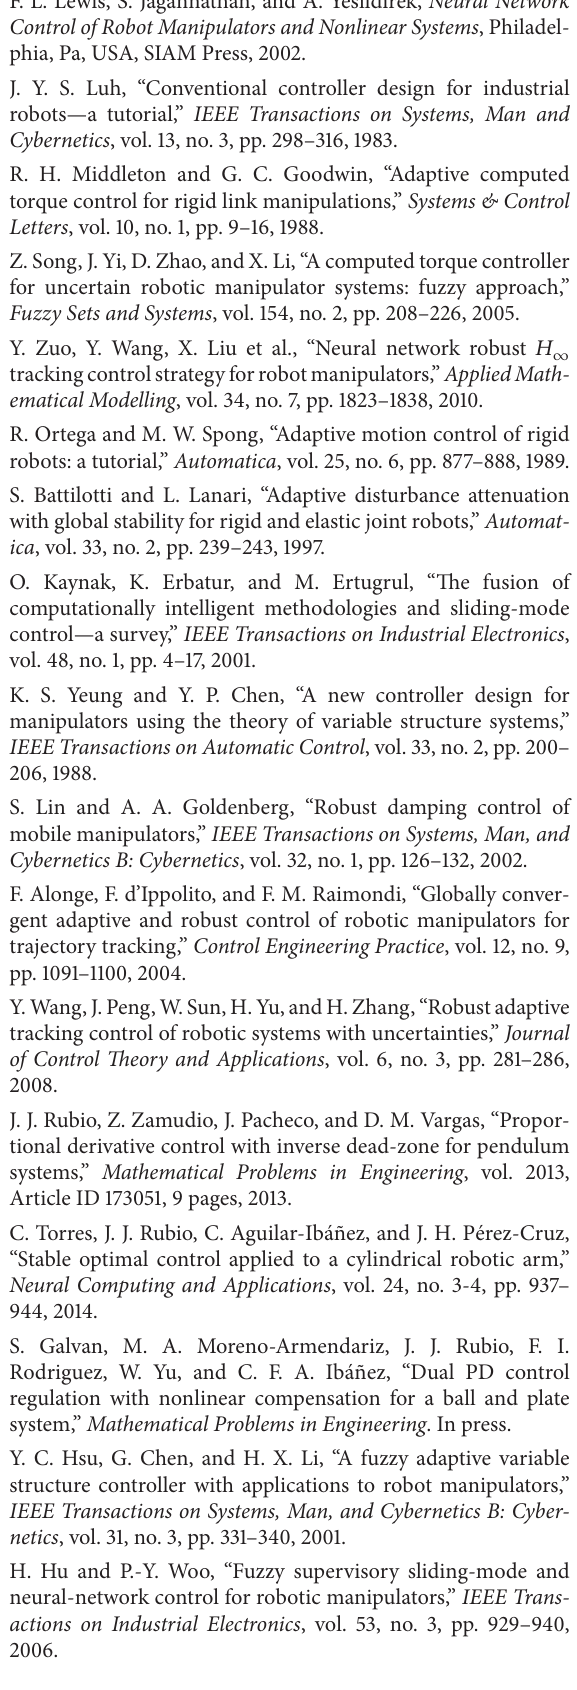
Table 1: 𝐿 2 norm for tracking